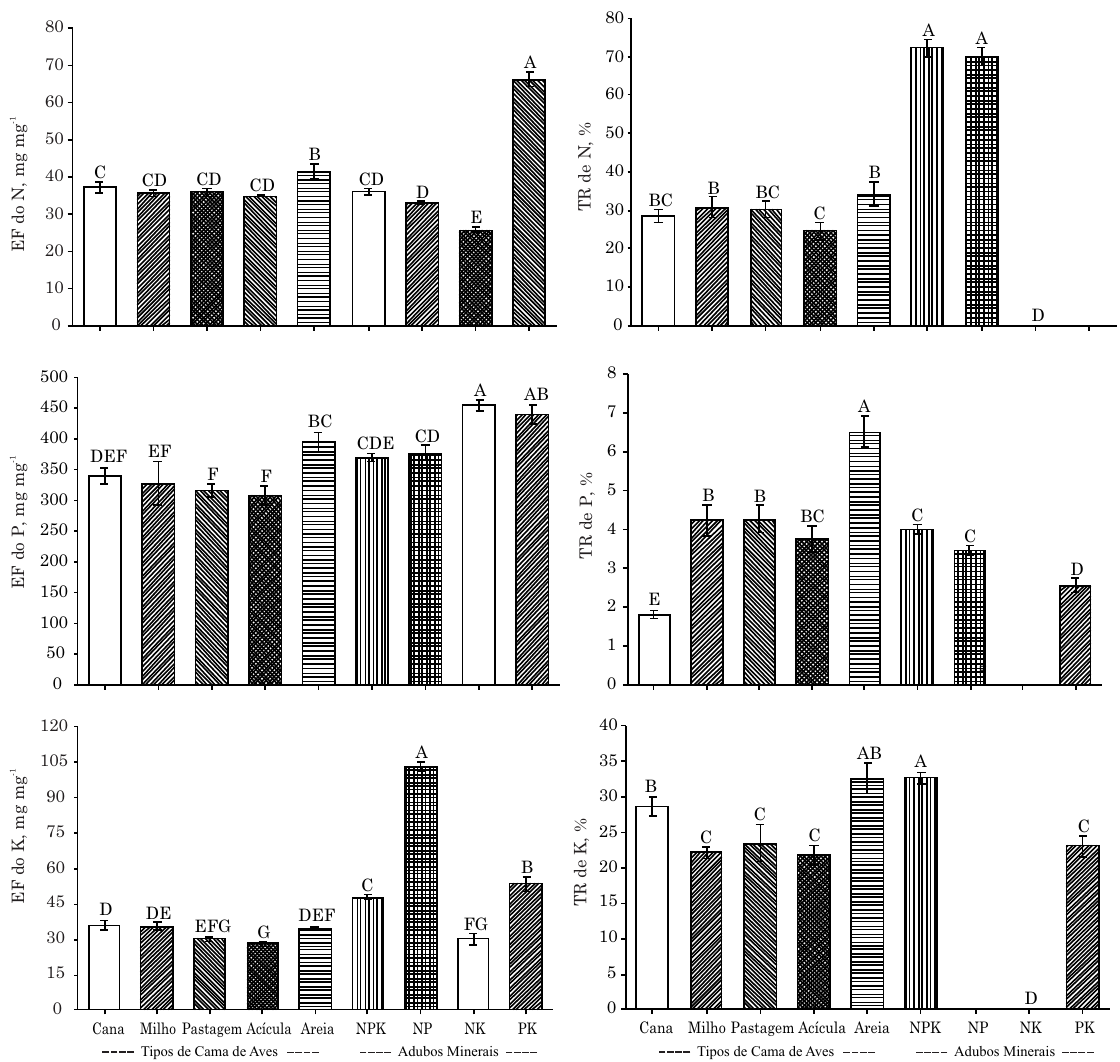
Figura 4. Eficiência fisiológica (EF) e taxa de recuperação (TR) do N, P e K pelo feijoeiro, aos 60 dias após a semeadura, em razão da adição de fontes orgânicas e minerais, em casa de vegetação. Barras nas colunas referem-se ao erro-padrão da média. Valores nas colunas de cada época de amostragem seguidos de mesma letra não diferem significativamente pelo teste da diferença mínima significativa (DMS) a 5 %. Tratamentos com taxa de recuperação zero atribuem-se aos tratamentos com ausência dos nutrientes, e ao tratamento sem a adição de P, por causa da menor absorção de NPK pelas plantas, em relação ao tratamento